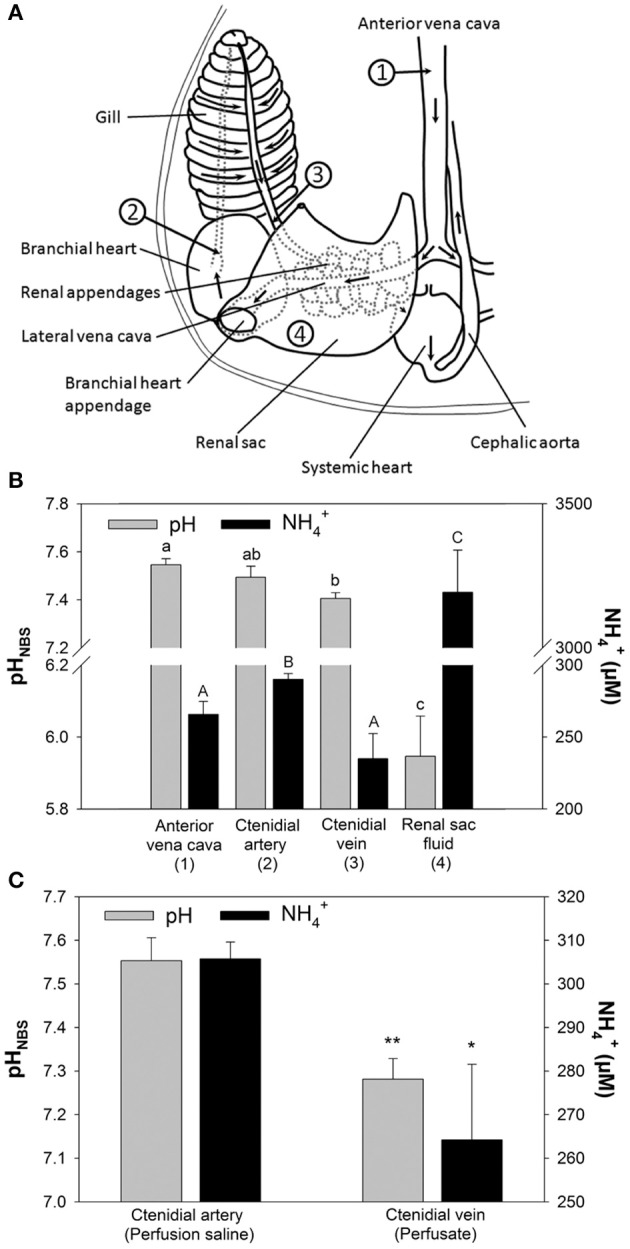
Determination of pH and NH4+ concentrations in perfused Octopus vulgaris gills. (A) Transit stations before and after passage of excretory organs including renal appendages, branchial heart appendages, and gills. Numbers indicate the sampling stations for in vivo measurements of blood pH and NH4+ concentrations shown in (B) (Figure modified after Potts, 1965). (B)
In vivo measurements for pH and NH4+ concentrations at different transit stations before and after passage of major excretory organs. (C) pH and NH4+ levels before (perfusion saline) and after gill passage (perfusate) in perfused gills. Values are presented as mean ± SE (n = 4–5) and capital letters denote significant differences between pH measurements whereas lower case letters denote significant differences between NH4+ measurements along the passage of excretory organs. Asterisks indicate significant differences of pH and NH4+ levels before and after gill passage in perfusion experiments.